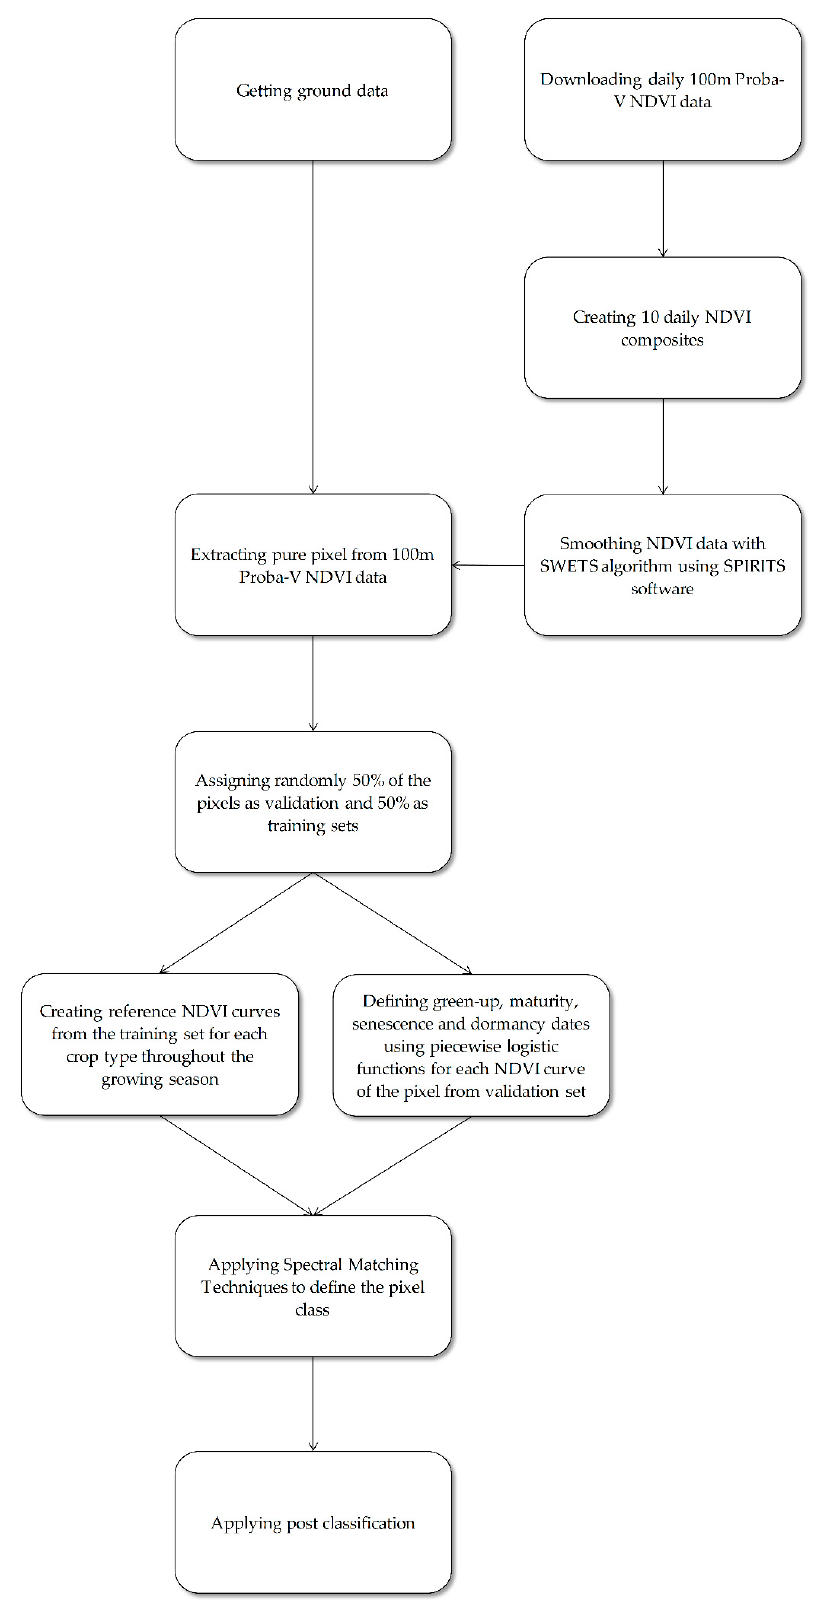
Figure 2. Flowchart of the crop mapping methodology.